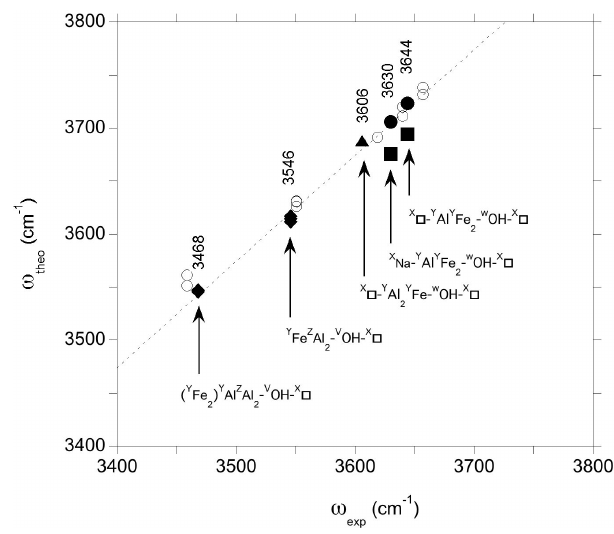
Figure 6. Relation between theoretical ( ω OH ) and experimental ( ω exp ) OH-stretching frequencies in foitite. The theoretical W OH and V OH frequencies are the PBE + U and PBE values, respec- tively (Table 2). Experimental frequencies (Table 1) are indi- cated. The dashed line corresponds to the equation ω OH = ω exp + 75cm − 1 . Filled circles: W OH in Y Fe Y Al environment with AFM 2 configuration; filled squares W OH in Y Fe Y Al environment with FM 2 configuration; triangle: W OH in Y Fe Y Al 2 configuration; diamonds: V OH groups; open circles: Mg-bearing clusters (Fuchs et al.,